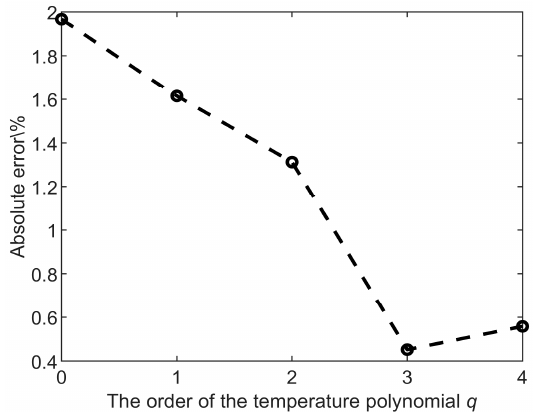
Figure 8. The compensation absolute errors are influenced by the fitting order q , when q = 3 is the optimal order of temperature polynomial q .